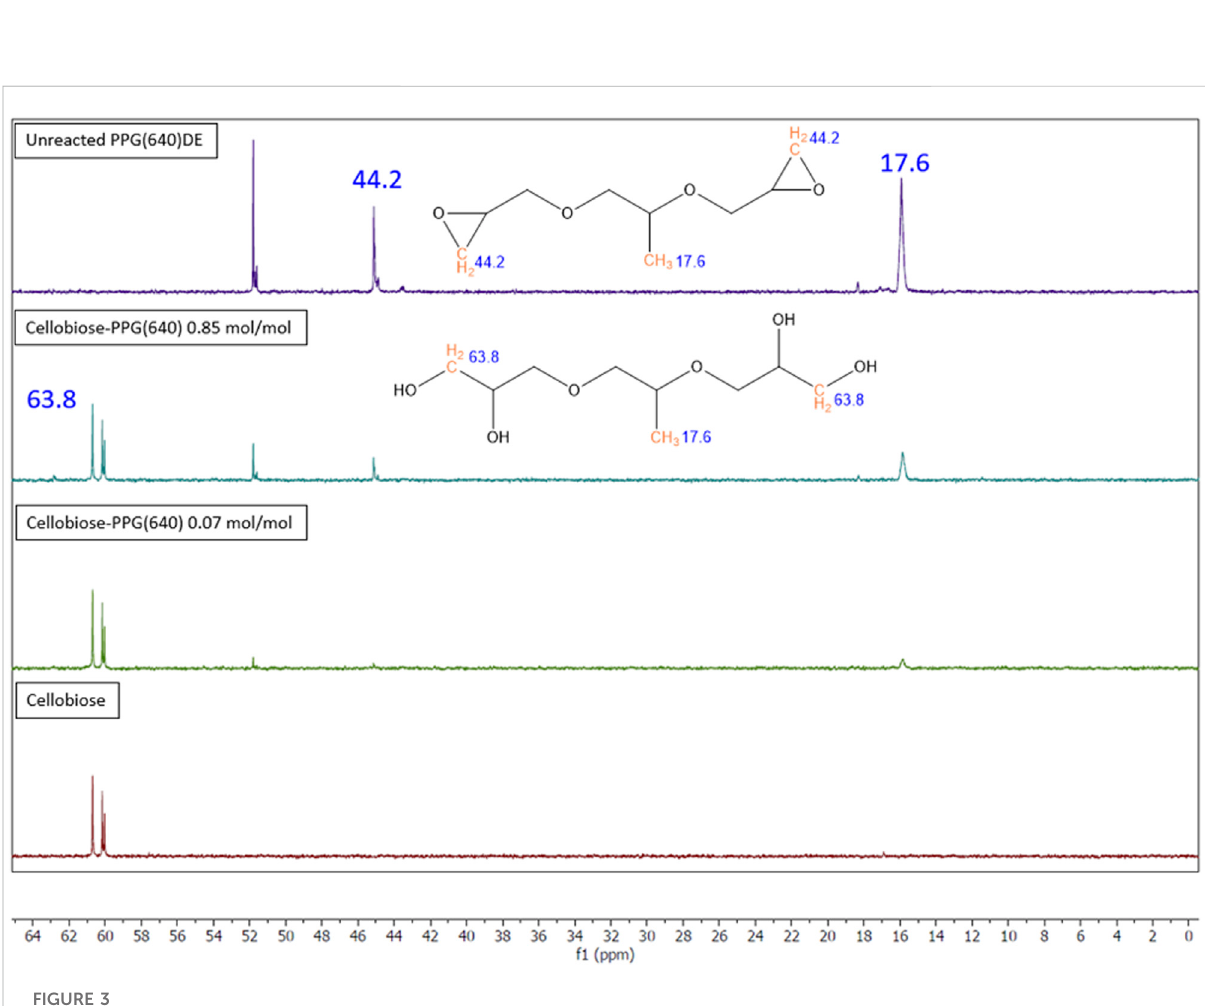
FIGURE 3 Solution 13C NMRspectra for crosslinkedand control samplesof cellobiose and PPG (640) DEwith theunreacted and hydrolysed structures of PPGDE shown.